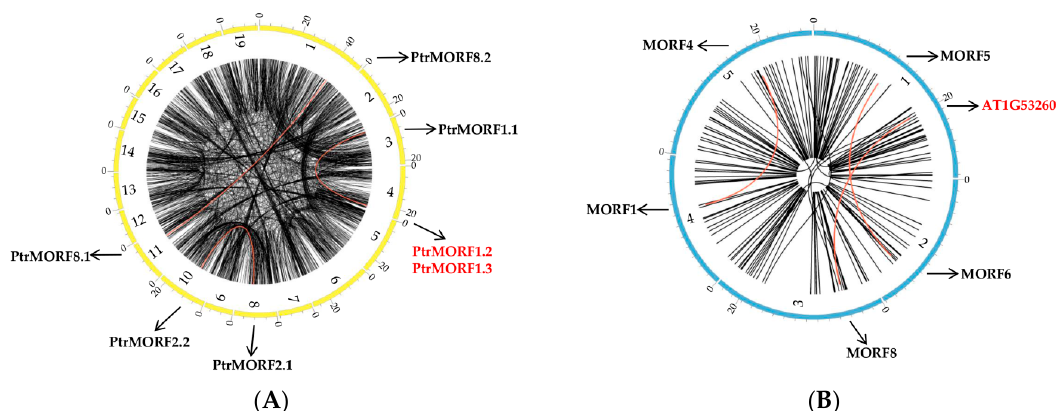
Figure 5. Interchromosomal relationships of MORF genes. ( A ) Interchromosomal relationships of MORF genes in poplar. ( B ) Interchromosomal relationships of MORF genes in A. thaliana . Black lines indicated all synteny blocks in the Populus or A. thaliana genome and the red indicated synteny blocks where MORF duplicated gene pairs were. The chromosome number was indicated at the bottom of each chromosome and each cell on the outside of chromosomes represented 5 Mbp in Populus and 1.5 Mbp in A. thaliana .